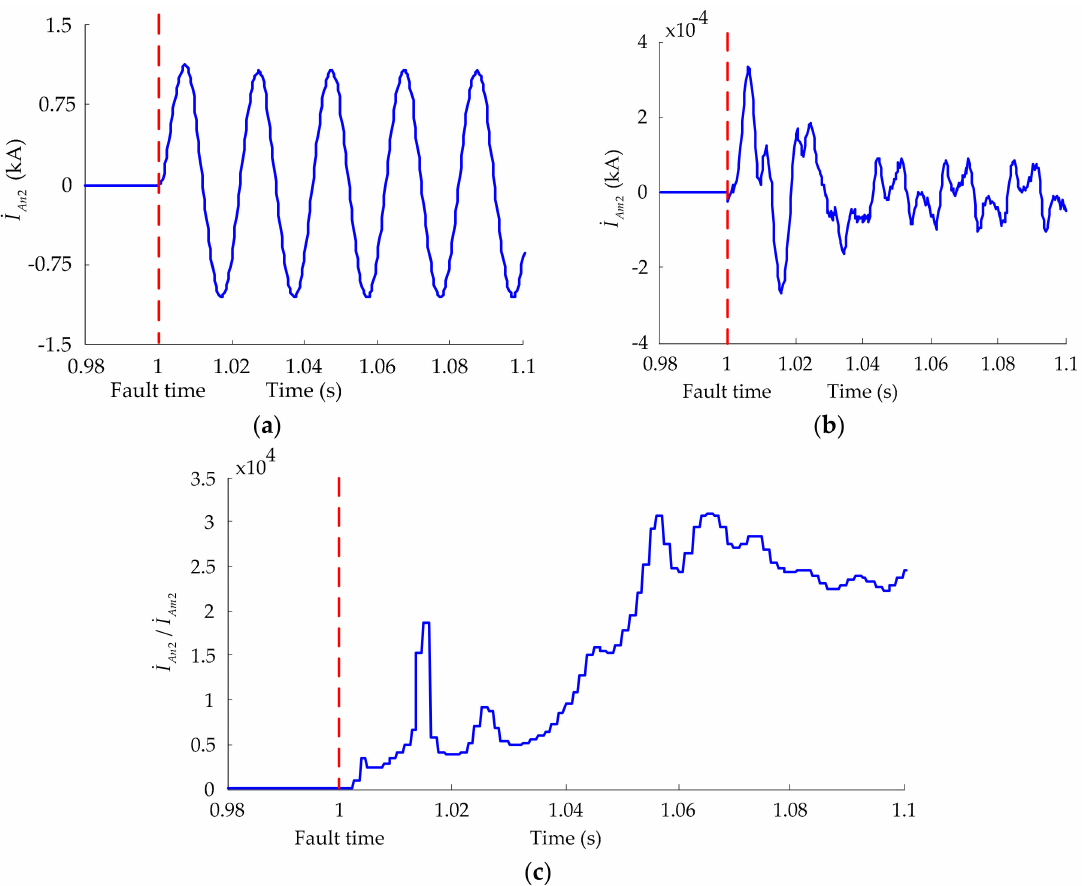
Figure 7. Simulation results of the negative-sequence fault currents under the phase-A-to-ground fault: ( a ) Negative-sequence fault current flowing from the bus n; ( b ) Negative-sequence fault current flowing from the bus m; ( c ) The ratio between negative-sequence currents.